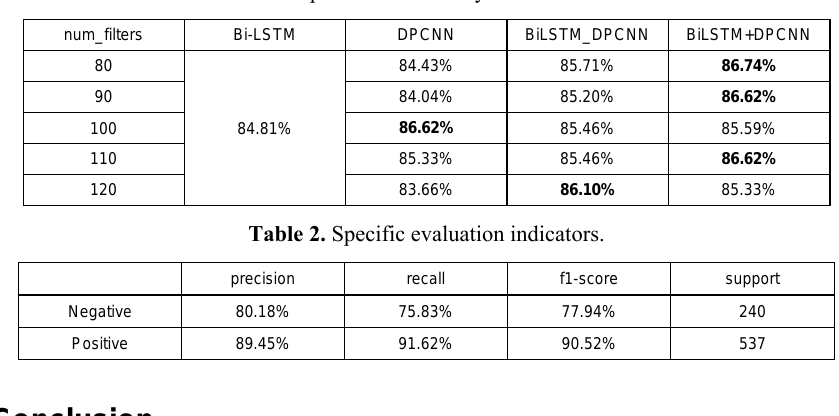
Table 1. Comparison of accuracy of different models.